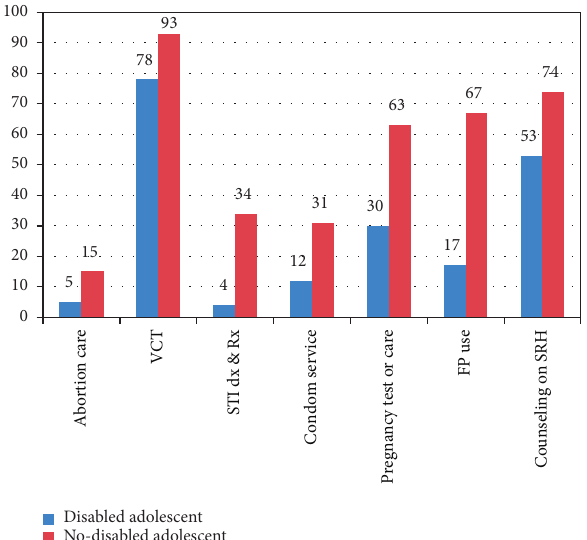
Figure 1: Magnitude of sexual and reproductive health service utilization by component among adolescents with or without disability in Arba Minch town school,